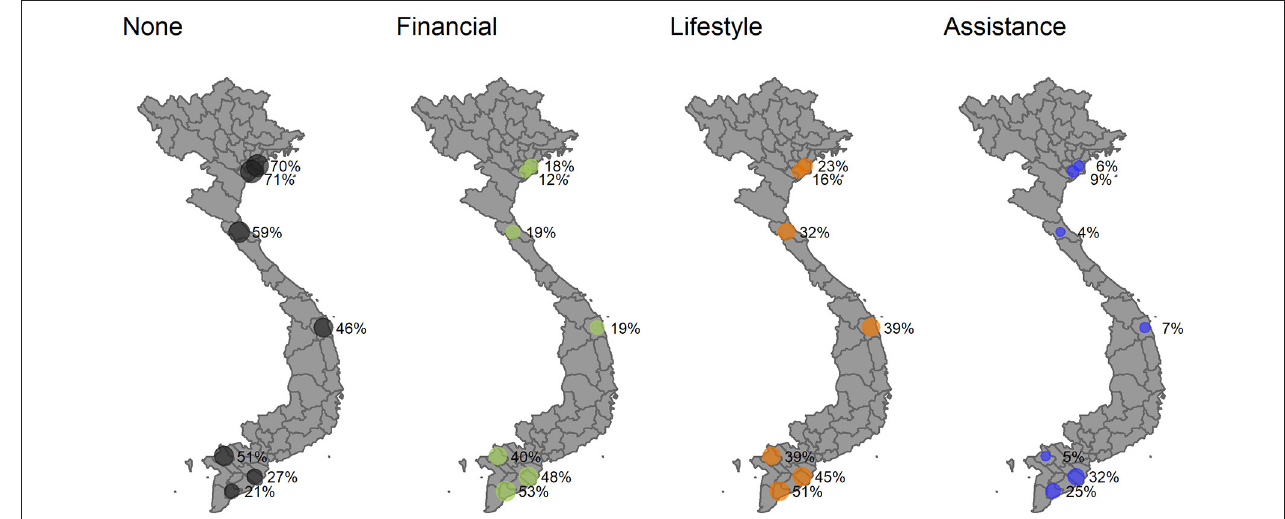
FIGURE 2 | Map showing the percent of respondents practicing household adaptations in each surveyed province.